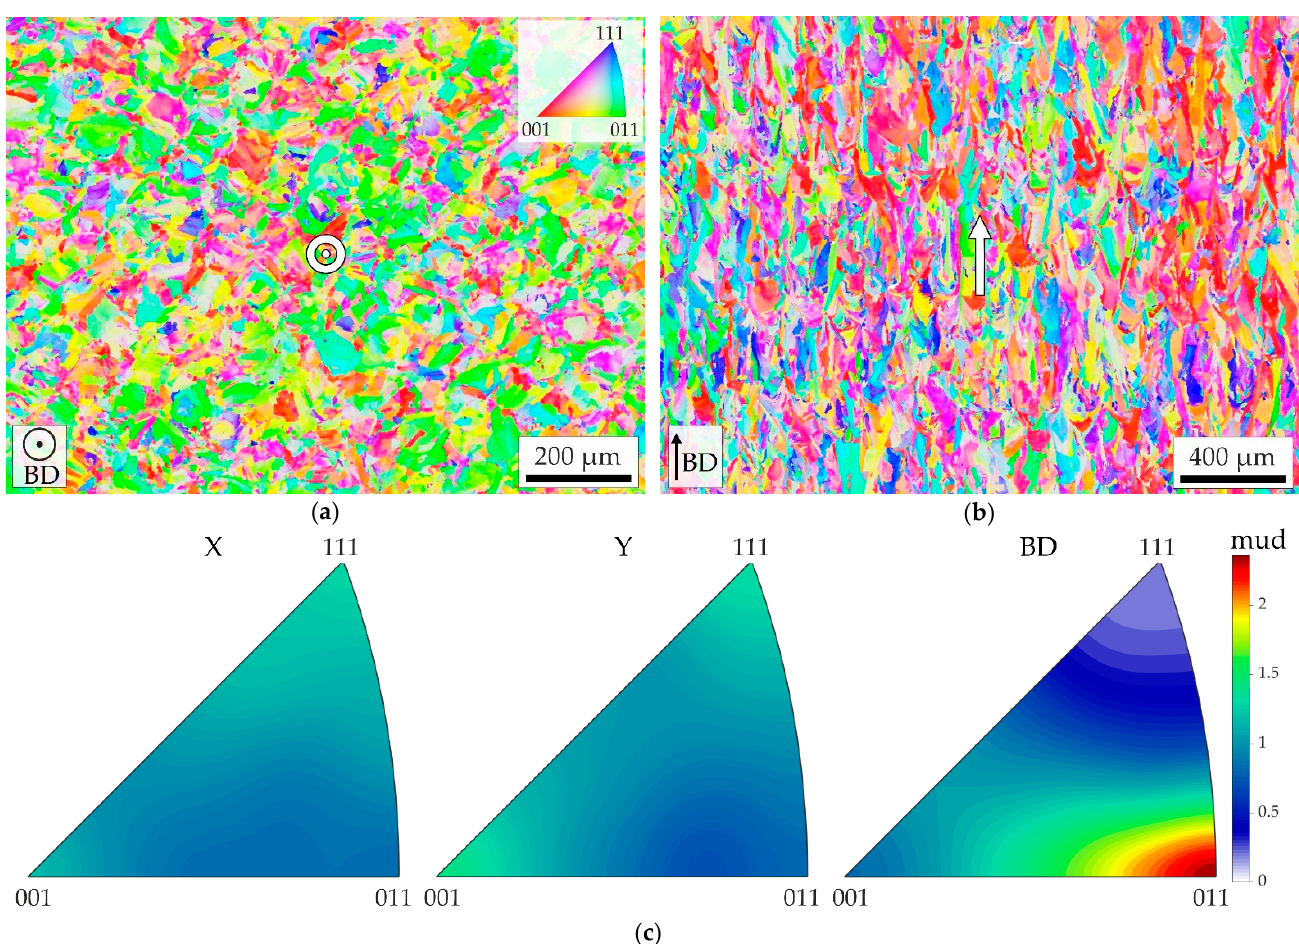
Figure 2. EBSD inverse pole figure (IPF) maps of sample planes ( a ) perpendicular to BD (X-Y), ( b ) parallel to BD (Y-BD) with the principal grain growth direction indicated by the centric white symbols, IPF color coding with respect to the sample surface, and ( c ) a representative IPF derived from an EBSD X-Y sample with the multiples of uniform distribution (mud) scale.